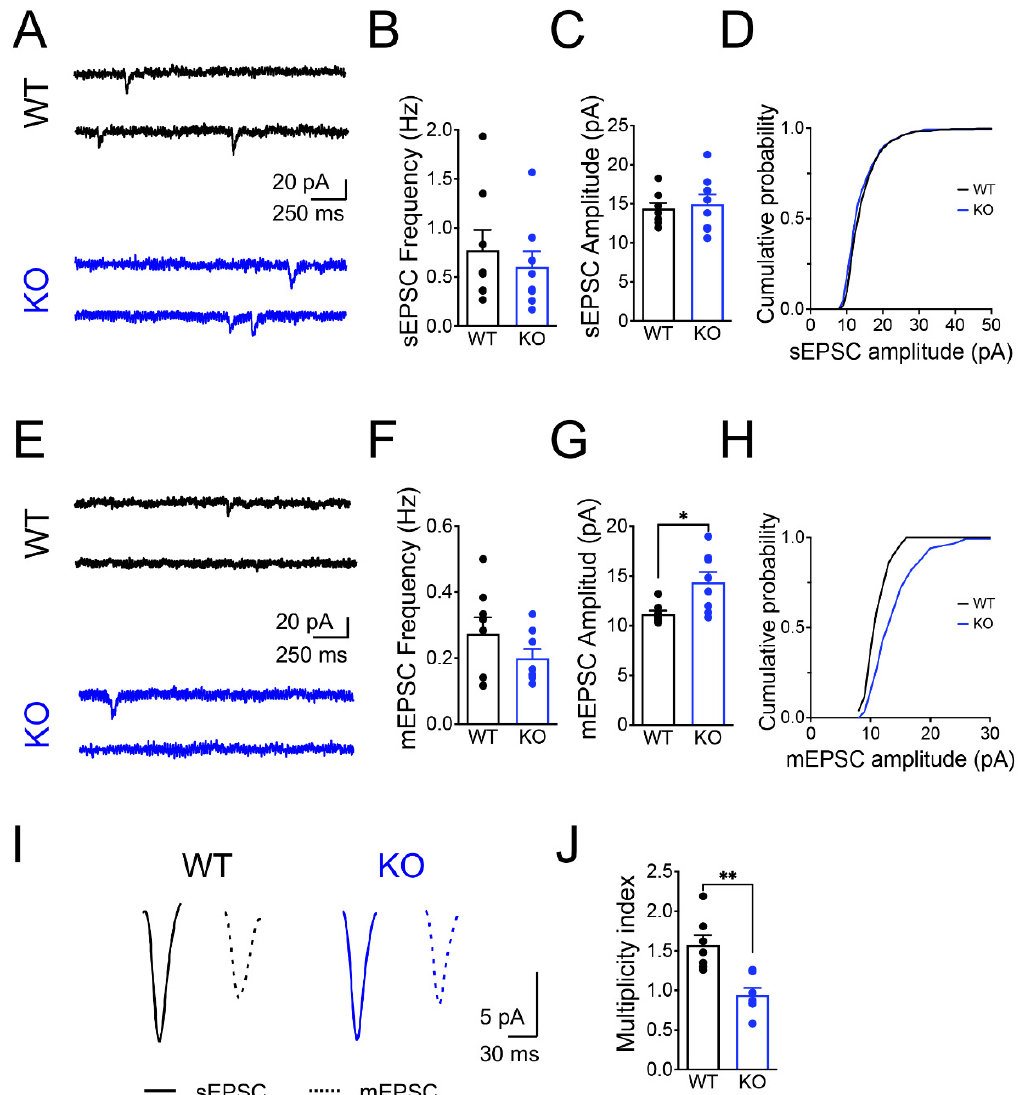
Panx1-KO neurons exhibited a greater proportion of mature-type spines than WT neurons (Figure 4K,L; WT versus KO * p = 0.02, ** p = 0.005, *** p < 0.001; two-way ANOVA test), indicating that the absence of Panx1 also induces significant structural changes in the spine morphology.